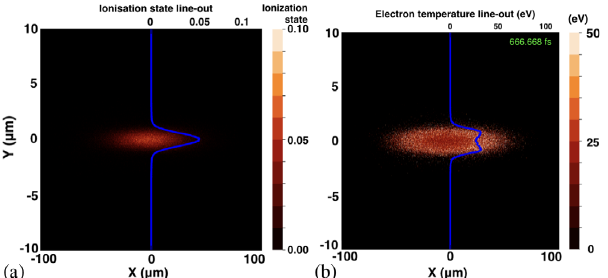
FIG. 3. (a) The blast-wave structure which evolves from the initial electron temperature profile induced by the laser pre-pulse. (b) A 1D slice of the density profile at X ¼ 0 , showing the characteristic blast-wave structure. Note this figure has been labelled with X and Y for consistency with the EPOCH simulations, in these simulations Y is in fact the radial dimension in the cylindrical coordinate system